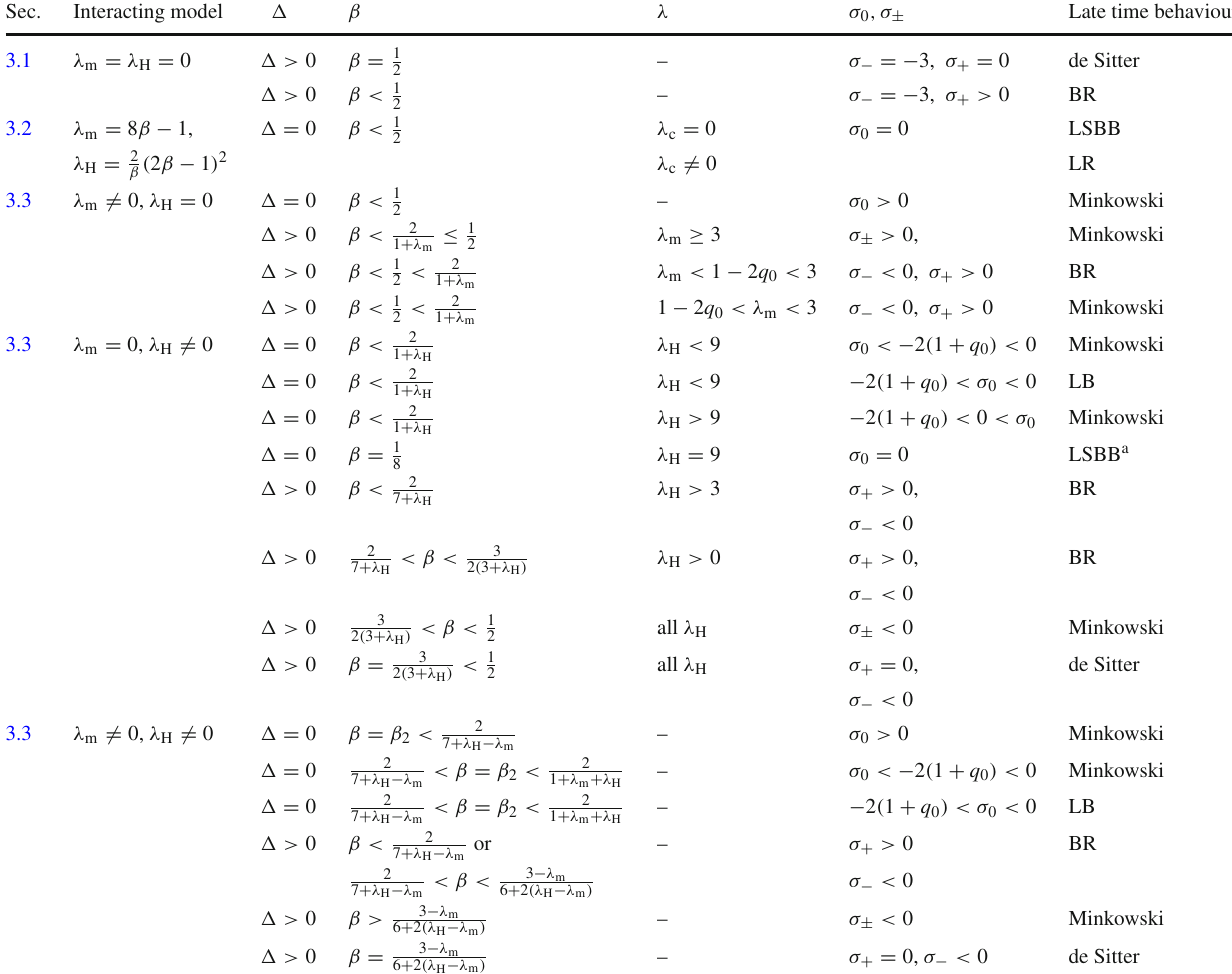
Table 1 Summary of the behaviours of the universe at late times, for the physical range of holographic parameters β < 1 DE interactions Sec. Interacting